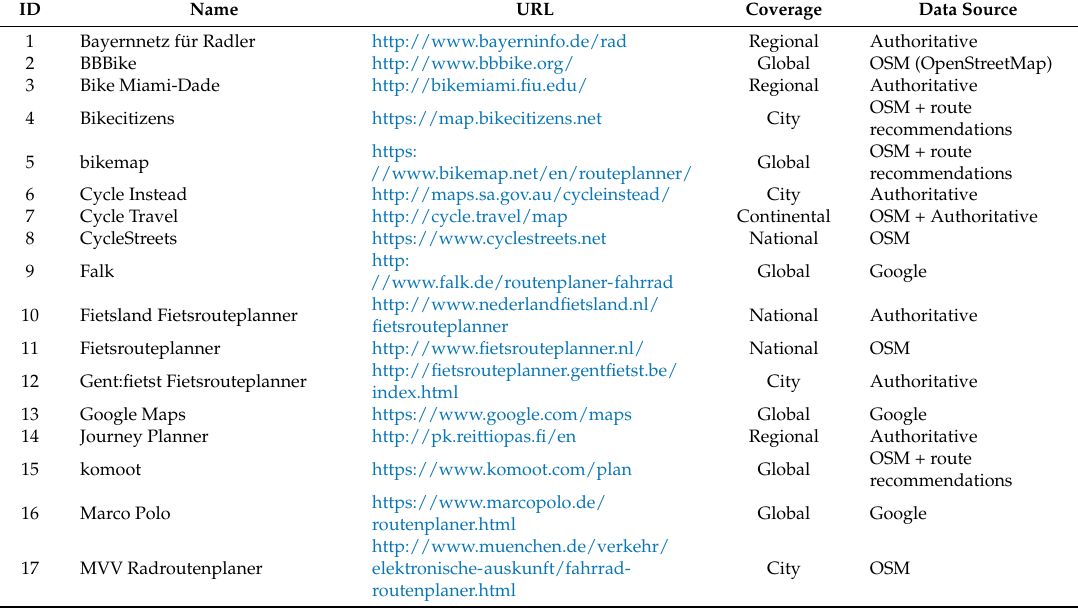
Table 2. List of the analyzed bicycle routing portals (last access 14 November